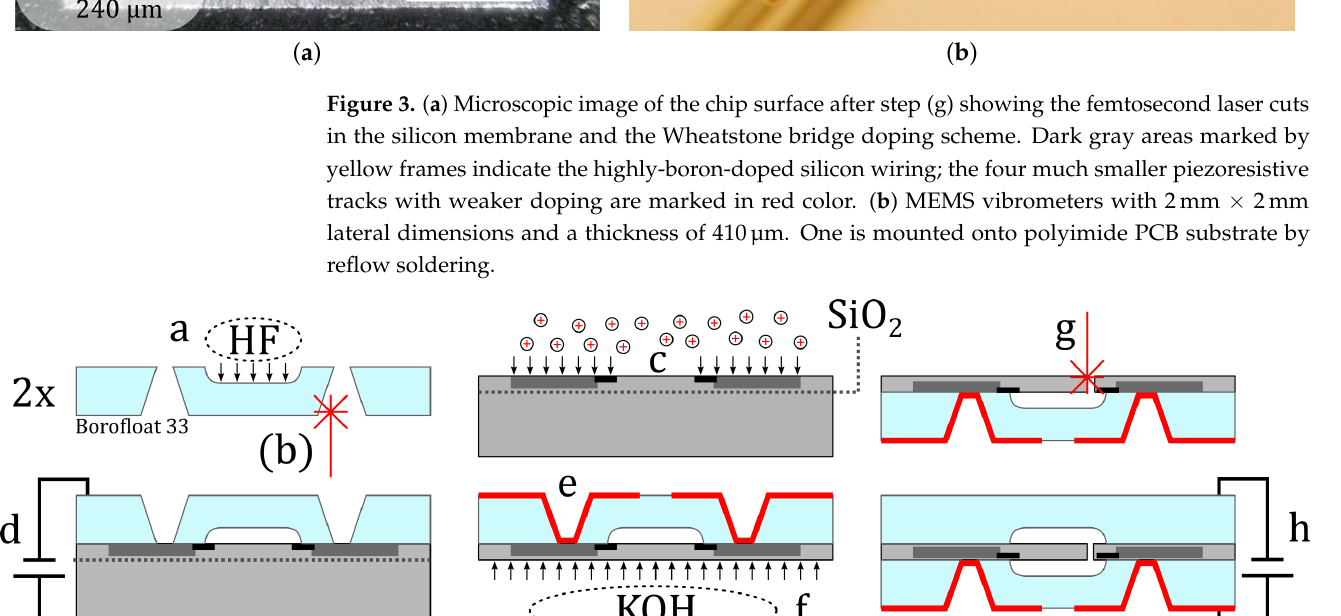
Figure 4. Illustration of the MEMS vibrometer microfabrication: ( a ) HF cavity etching into borofloat wafer; ( b ) through-glass vias by fs-laser ablation; ( c ) local boron-doping of the SOI device layer; ( d ) anodic bonding of SOI and borofloat wafers; ( e ) metallization by Cr+Au magnetron sputtering and successive Cu electroplating; ( f ) removing handle layer by KOH etching; ( g ) fs-laser cutting cantilever into membrane; ( h ) encapsulation by anodically bonding a glass